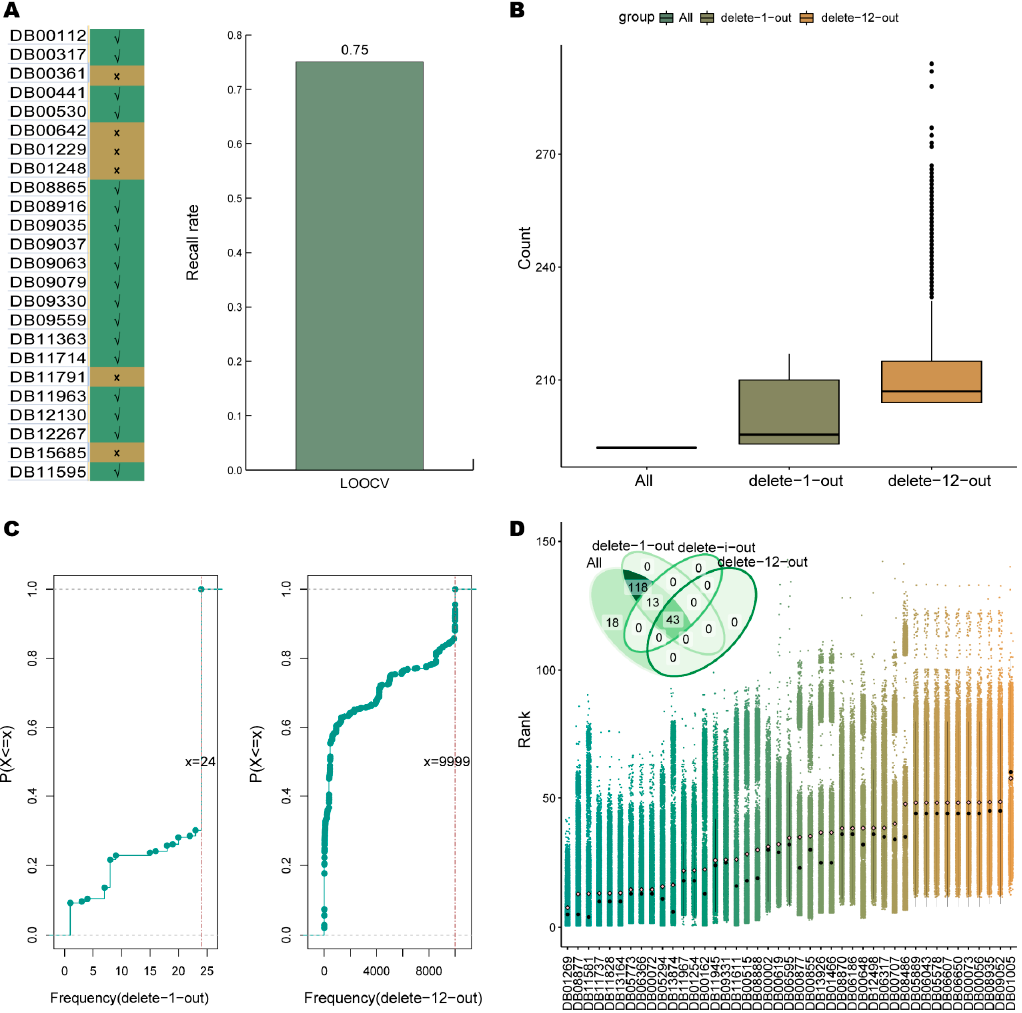
Figure 2. Stable drug candidates in unweighted pattern. ( A ) The recall of the leave-one-out cross validation. “ √ ” means the drug was recalled in the top 5% of drugs, and “×” denotes that the drug was not recalled. ( B ) Distribution of the number of the top 5% of drugs. “ALL” represents all known therapeutic drugs as a seed set. ( C ) Frequency distribution. The orange dashed line shows the 95th percentile of the distribution. ( D ) Distribution of the ranking for the stable drug candidates in the unweighted pattern. Where the average ranking is marked by a pink diamond and the median is marked with a black dot. In addition, the Venn diagram of the top 5% of drugs filtered with different number of seeds removed is inserted.